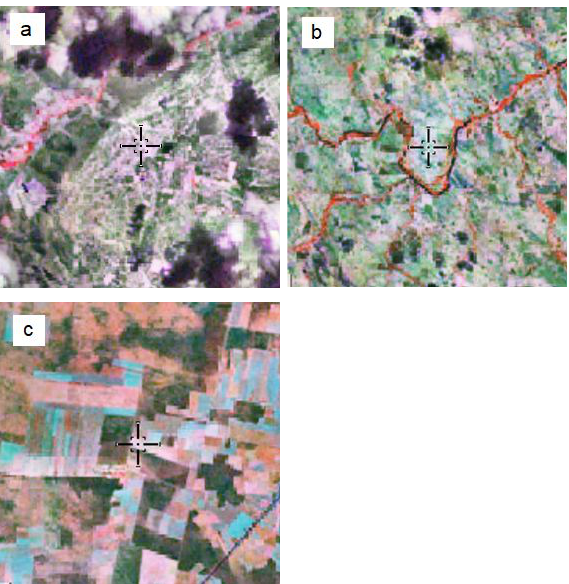
Figure 8a. Natural Pasture, grassland formation or presence of clouds; Figure 8b. Cultivated pasture; Figure 8c. Perennial